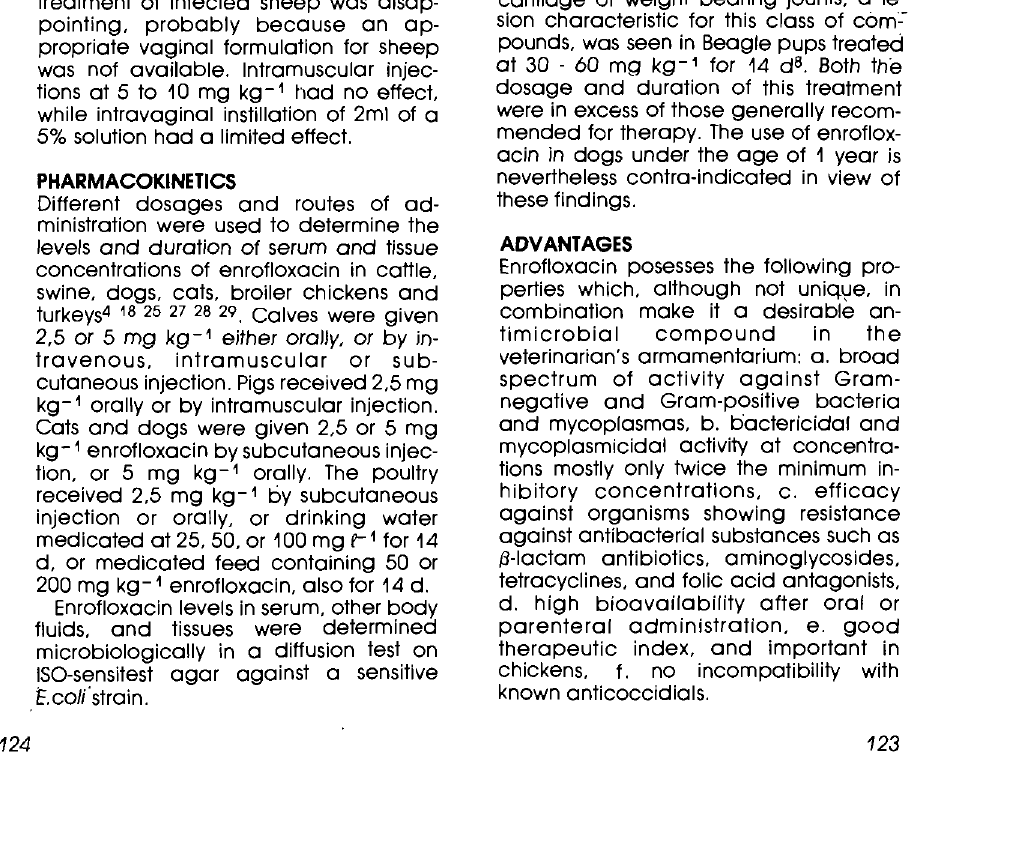
APPLICATIONS The efficacy of